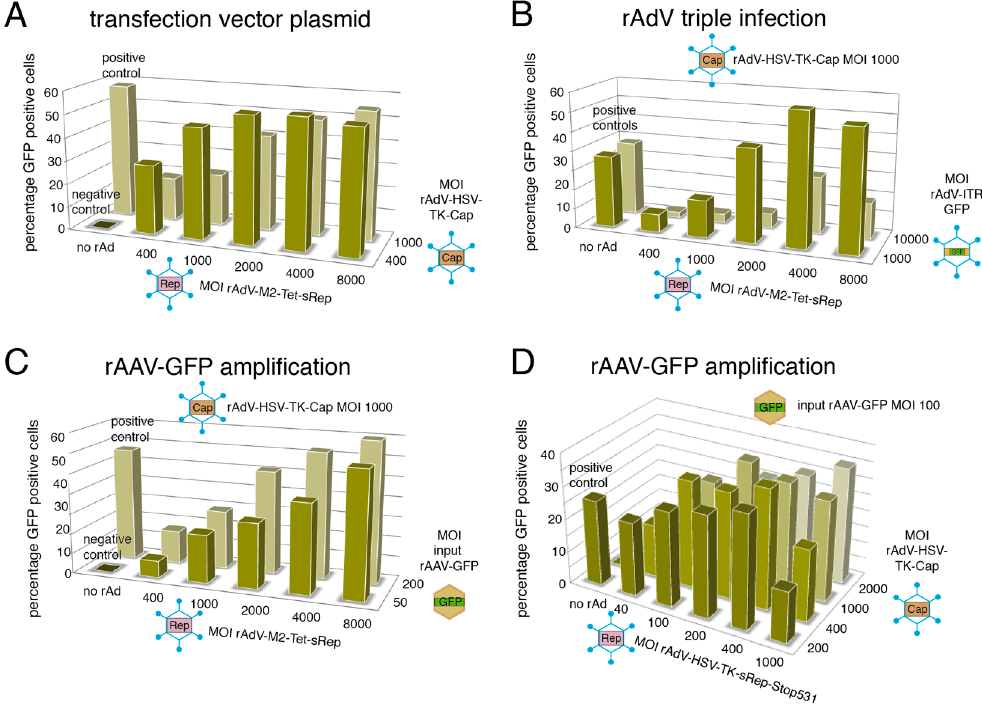
Figure 5. Optimization of rAdV-mediated rAAV2-GFP vector packaging. ( A ) to ( D ) Percentage of GFP positive cells obtained after transduction of 2 × 10 5 HeLa cells with small aliquots of freeze–thaw lysates from packaging experiments performed with 5 × 10 5 HEK293 cells in 6-well plates. For ( A ) to ( C ), 1/15 shares of the primary freeze–thaw lysates were used for transduction, while in ( D ) 1/30 shares were used. (A) to ( C ) correspond to the setups I to III illustrated in Figure 4 with rAdV-M2-Tet-sRep for expression of Rep proteins, while ( D ) corresponds to the setup III (rAAV-GFP amplification) with rAd-HSV-TK-sRep-Stop531 used for Rep expression. Input MOIs of the different vectors are indicated.